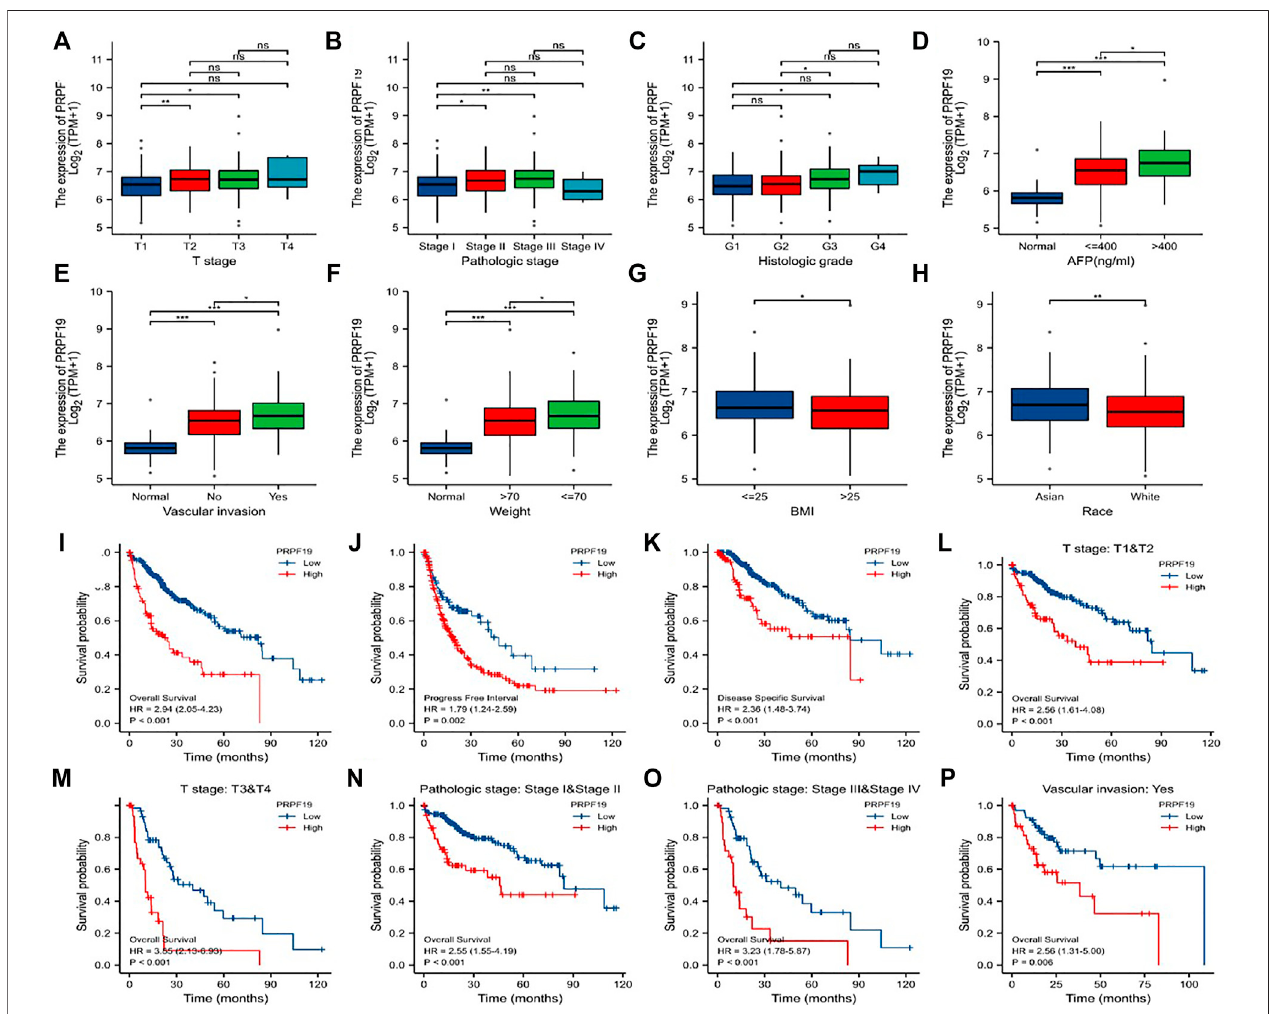
FIGURE 3 | Association of PRPF19 expression with clinicopathologic characteristics of LIHC (TCGA). (A) T stage. (B) Pathologic stage. (C) Histologic grade. (D) AFP level. (E) Vascularinvasion. (F) Patients ’ weight. (G) BMI. (H) Race. (I – K) LIHCpatientswithhigherexpressionsofPRPF19haveshorter OS,PFI, DSScompared to those with lower expressions of PRPF19. (L – P) Patients with higher PRPF19 have poor OS in T stage, pathologic stage, and vascular invasion subgroups. * p < 0.05, ** p < 0.01, *** p < 0.001.